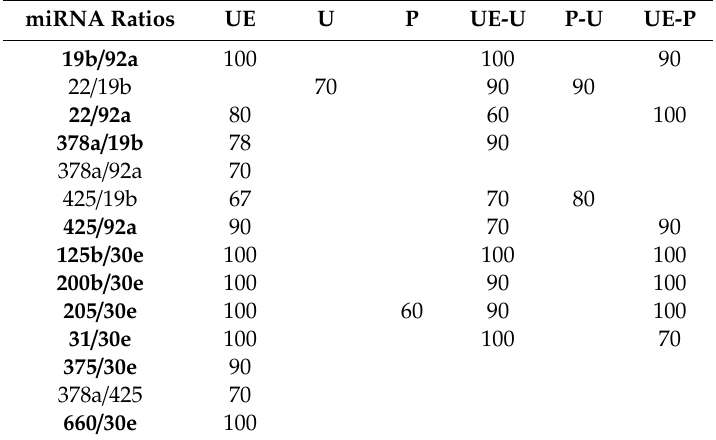
Table 4. ROC curve analysis: PCa vs. HD, sensitivity at 100% specificity.